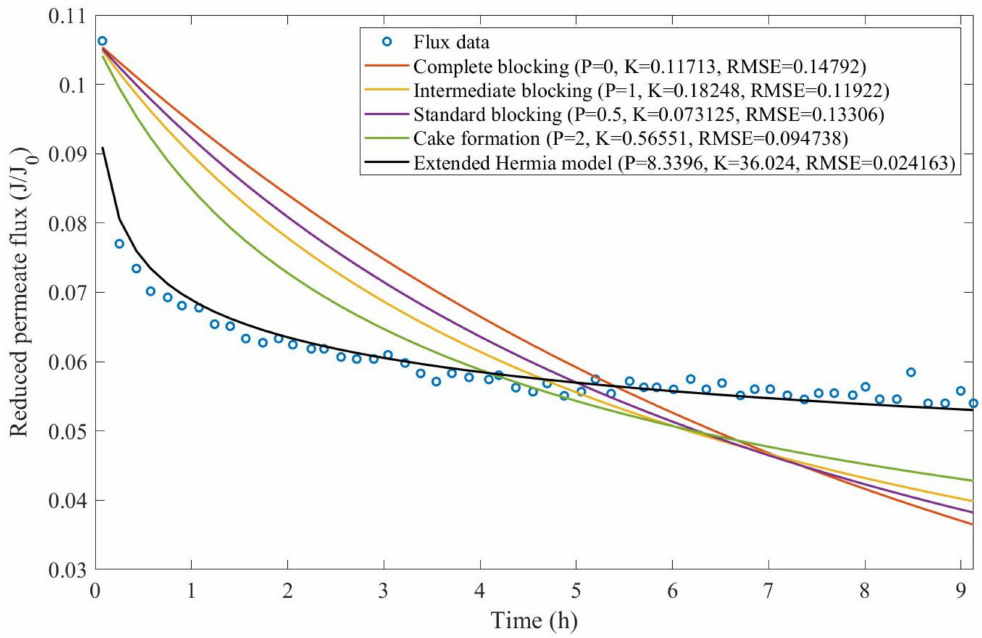
Figure A28. Model fitting for ultrafiltration of flooding wastewater at 2.20 bar and cross-flow velocity of 2.25 m/s considering the four original pore blocking mechanisms and the extended Hermia model (25).